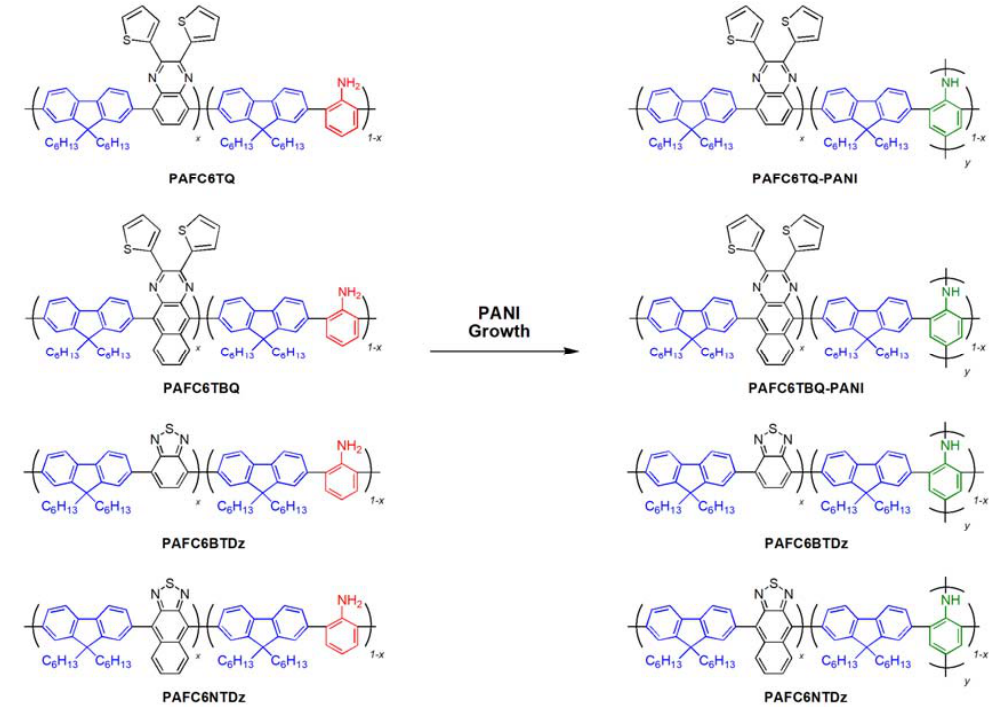
Scheme 2. Representation of 2D ‐ conjugated polymer structures.